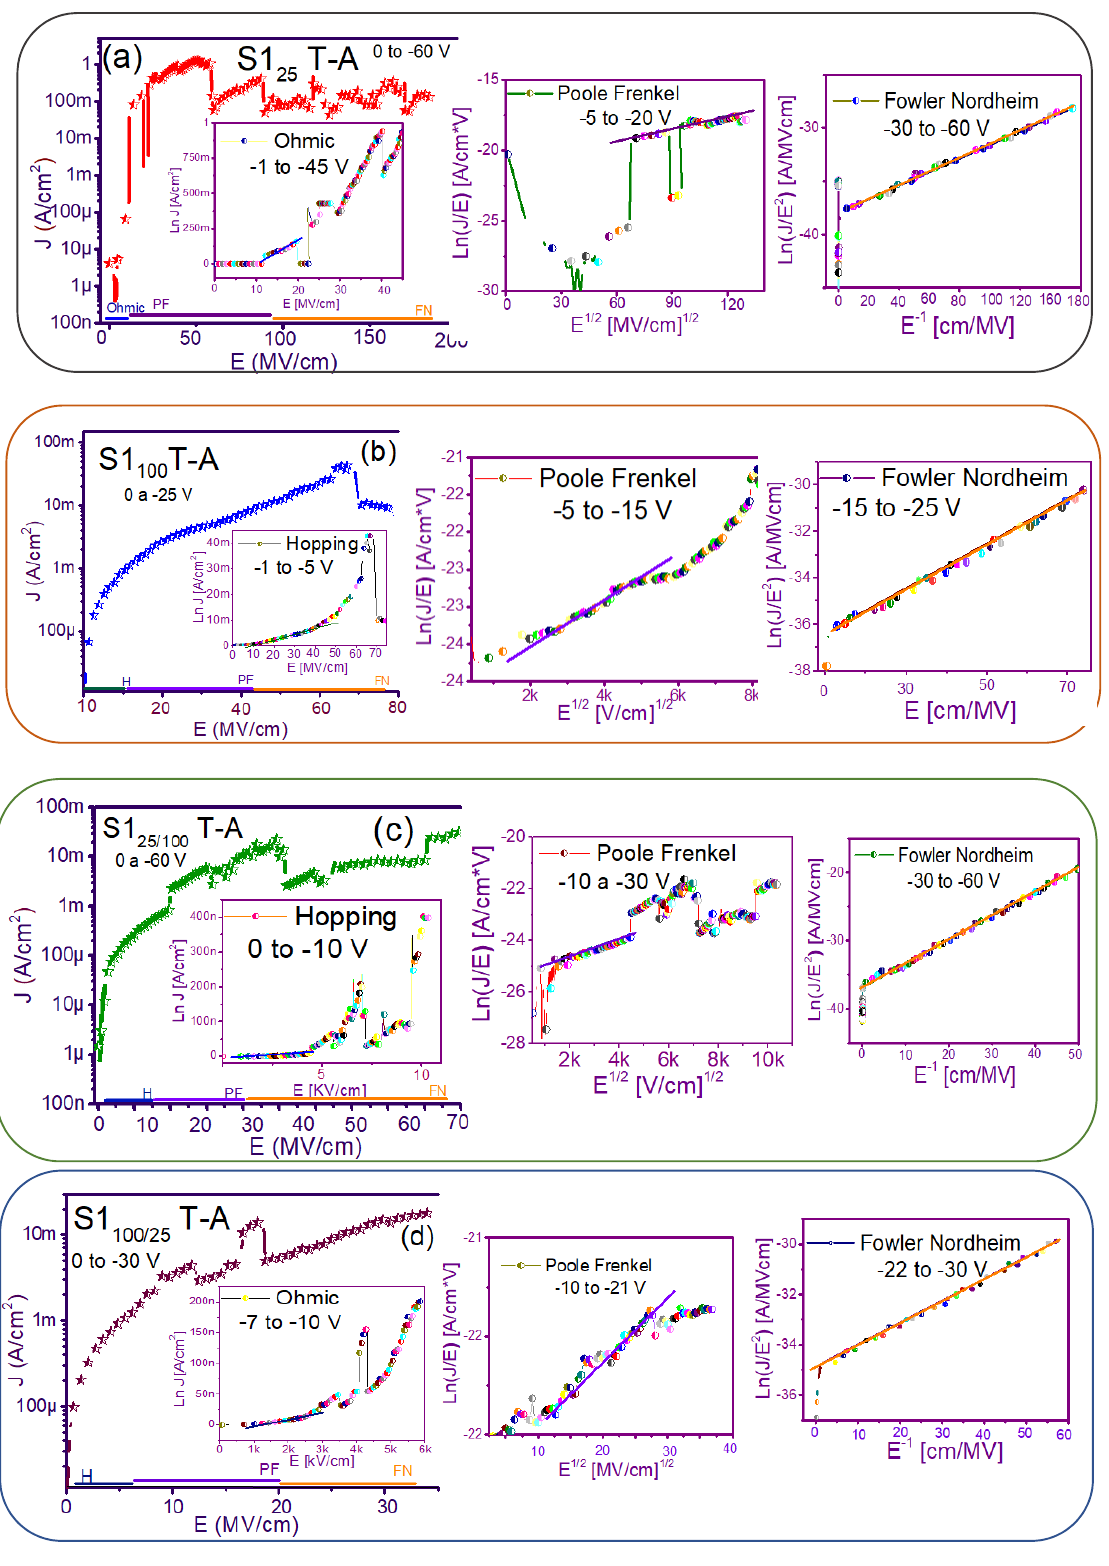
Figure 7. Conduction mechanisms ( a ) S1 25 T-A, ( b ) S1 100 T-A, ( c ) S1 25/100 T-A, ( d ) S1 100/25 T-A., with its corresponding J-E curve.